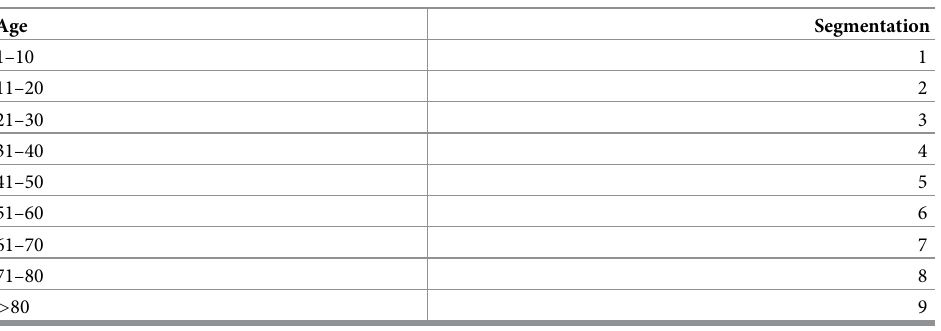
Table 2. Segmentation of user